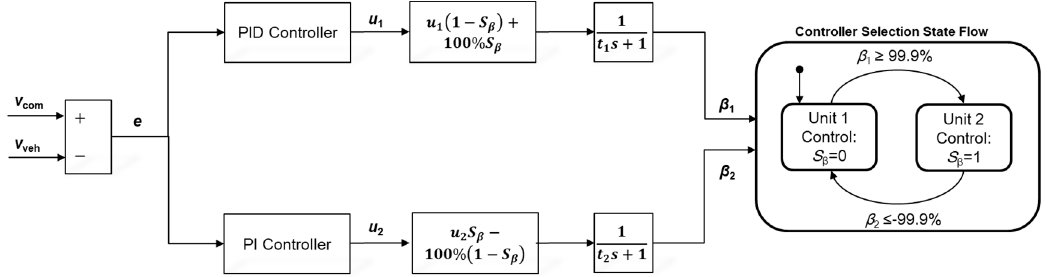
Figure 6. Wheel loader velocity controller.